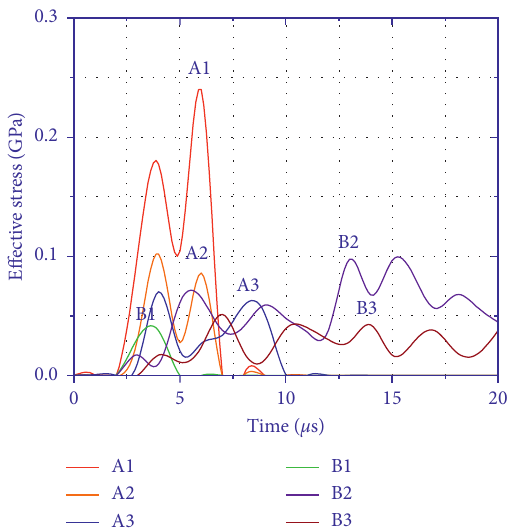
Figure 17: Stress curve of anhydrous bag-charge blasting unit.